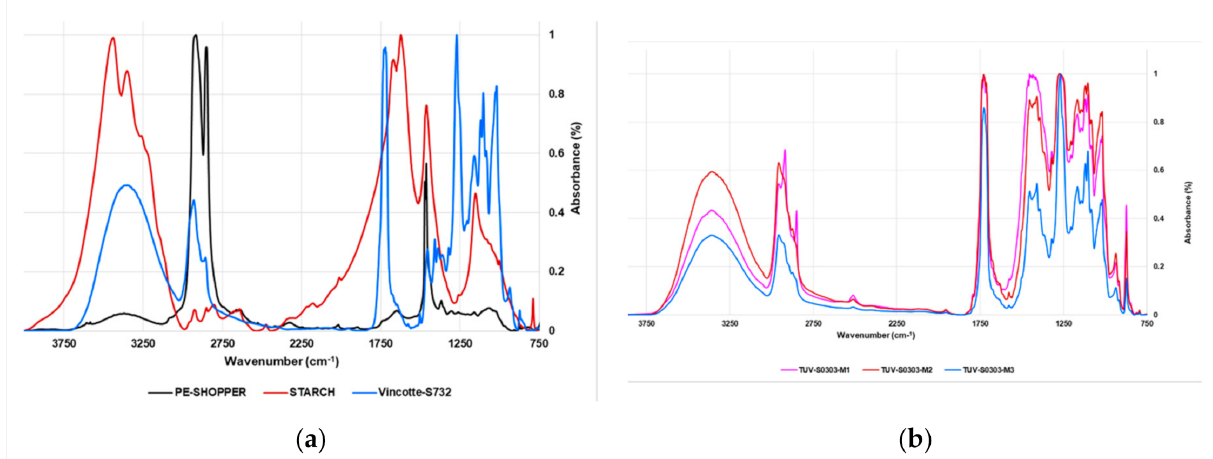
Figure 5. Comparison between the FTIR spectra of starch, a PE-based film, and Vinçotte-S732 ( a ); FTIR spectra of samples M1, M2, and M3 recently extruded and supplied by MecPlast for the study ( b